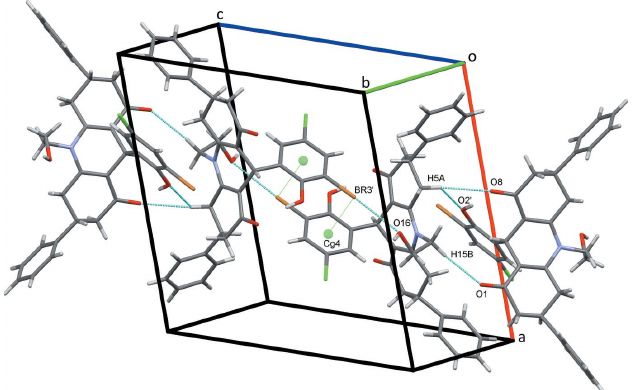
Figure 5 Chains of molecule of (I) formed by C—H (cid:2)(cid:2)(cid:2) O hydrogen bonds, C— Br (cid:2)(cid:2)(cid:2) (cid:2) and O (cid:2)(cid:2)(cid:2) Br contacts, dotted green lines.